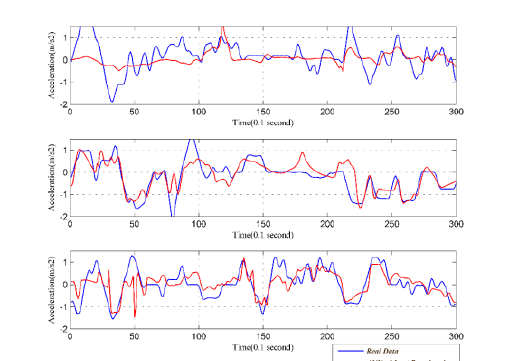
Figure 2. Artificial Neural Network prediction without considering the reaction